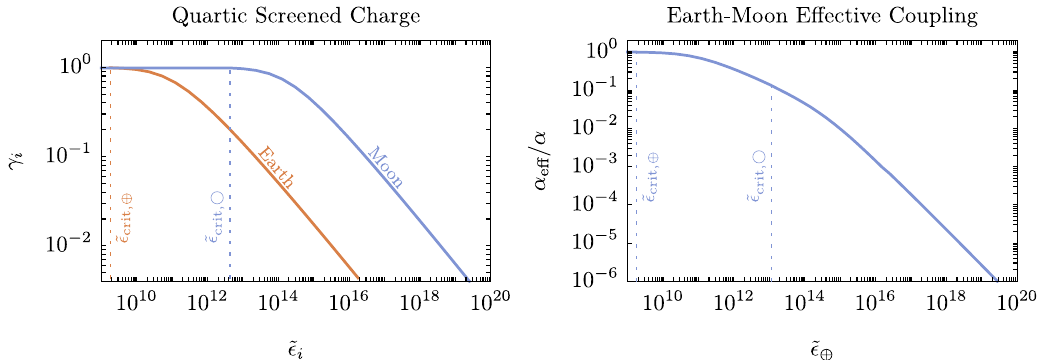
Figure 2 . E(cid:11)ective charges of the Earth and the Moon (left panel) and the resulting e(cid:11)ective coupling (right panel) as a function of the ’ quartic self-interaction (cid:15) (in units of p (cid:12)(cid:26) i { m 3 q 2 , with 0 (cid:26) i the density of the source and m (cid:1) 1 set to the Earth-Moon distance). Experimental bounds on the 0 (cid:12)fth force coupling are signi(cid:12)cantly weakened when screening becomes e(cid:11)ective inside the Earth and the Moon. These \thresholds" are indicated by vertical dashed lines in each panel. They correspond to the e(cid:11)ective mass of ’ becoming comparable to the source